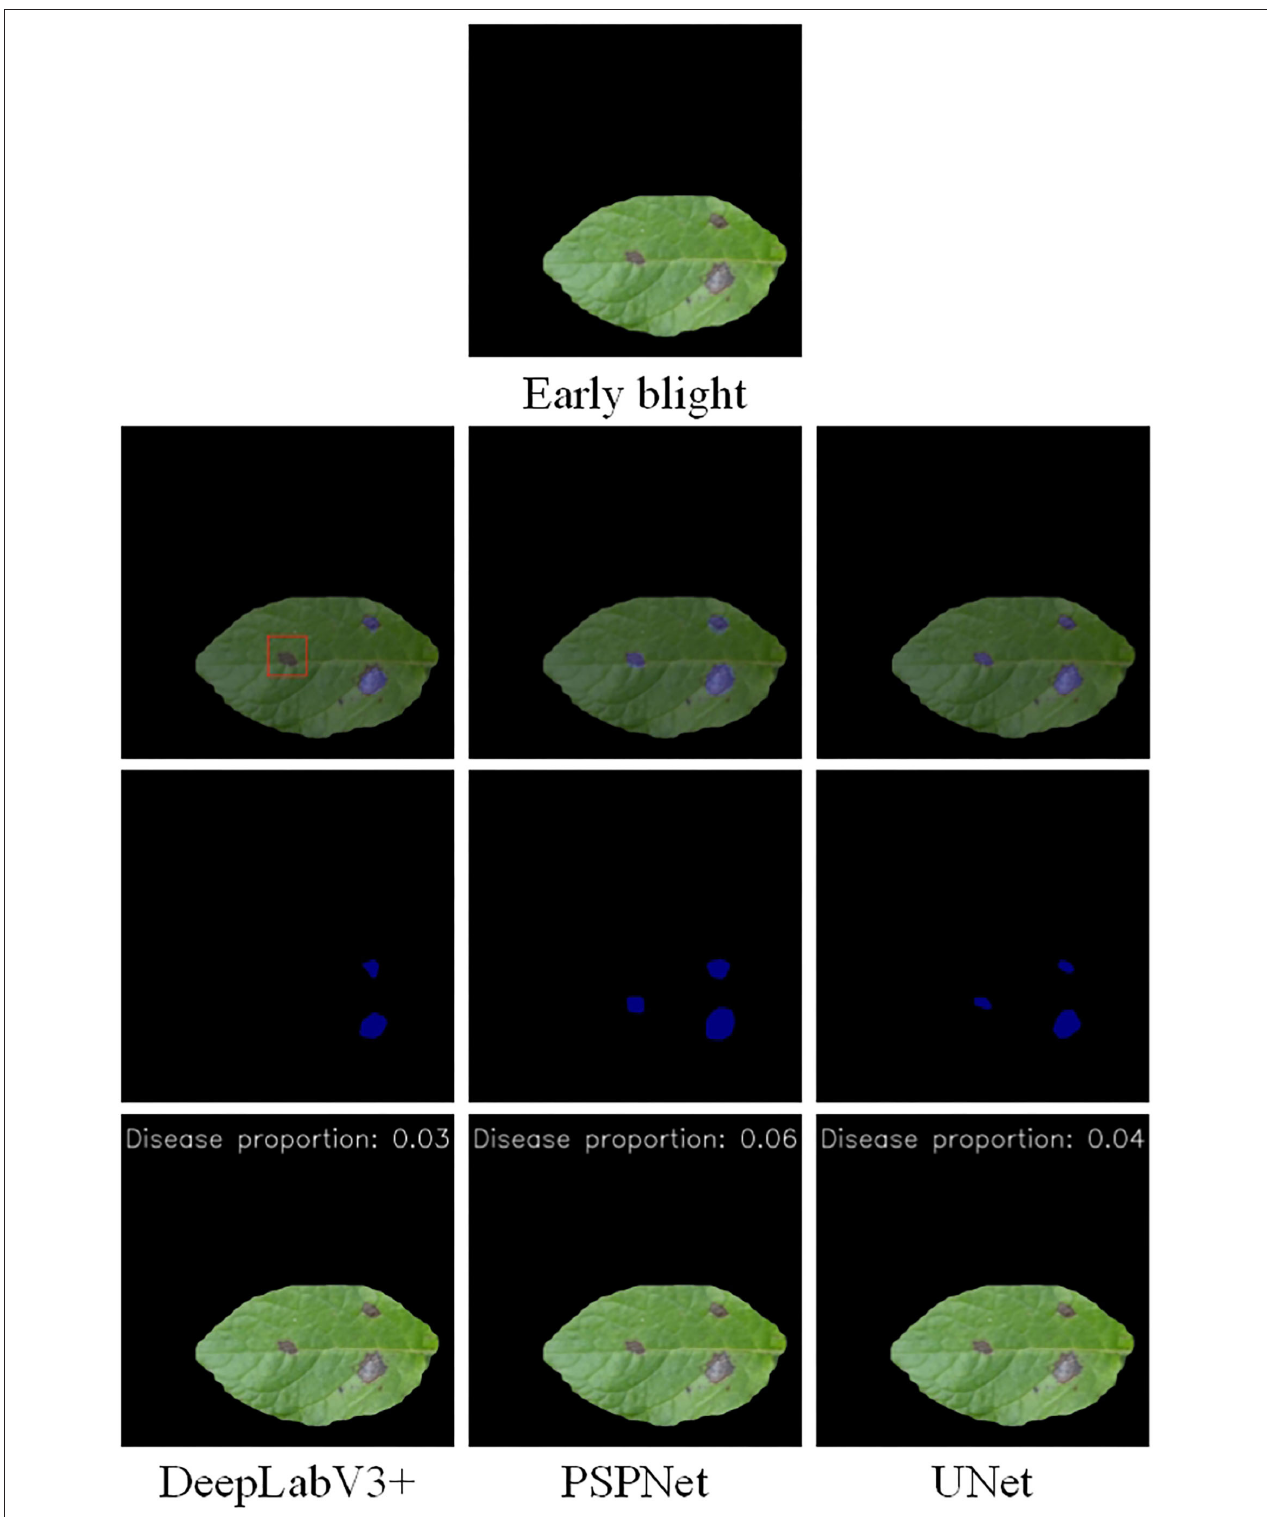
FIGURE 7 | Semantic segmentation results of early blight under the three models.